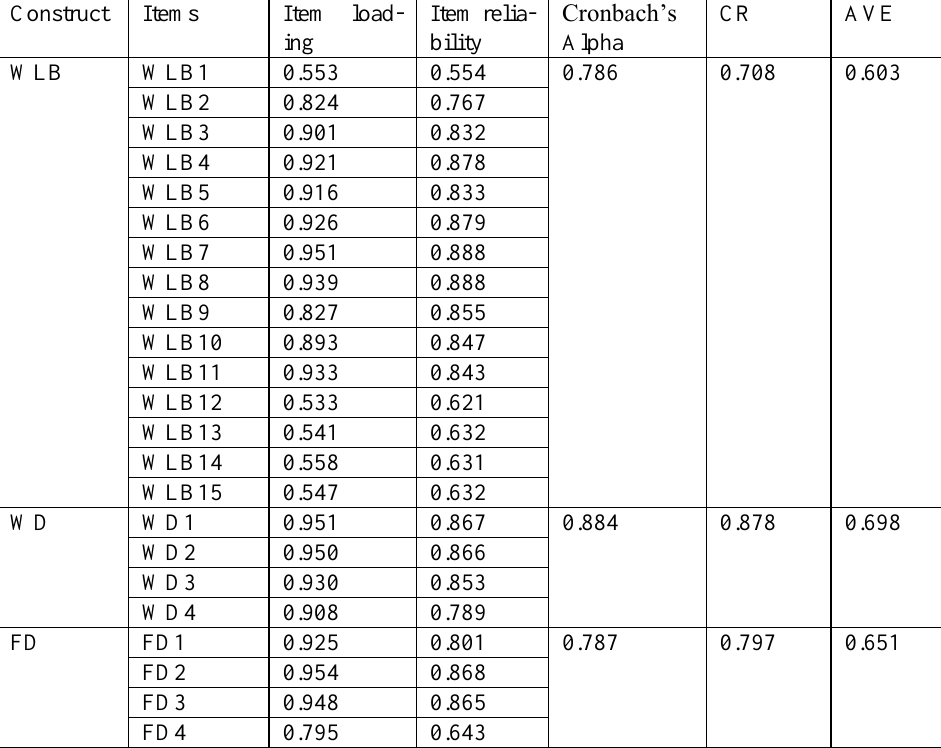
Table 1: Results of Assessing the Measurement